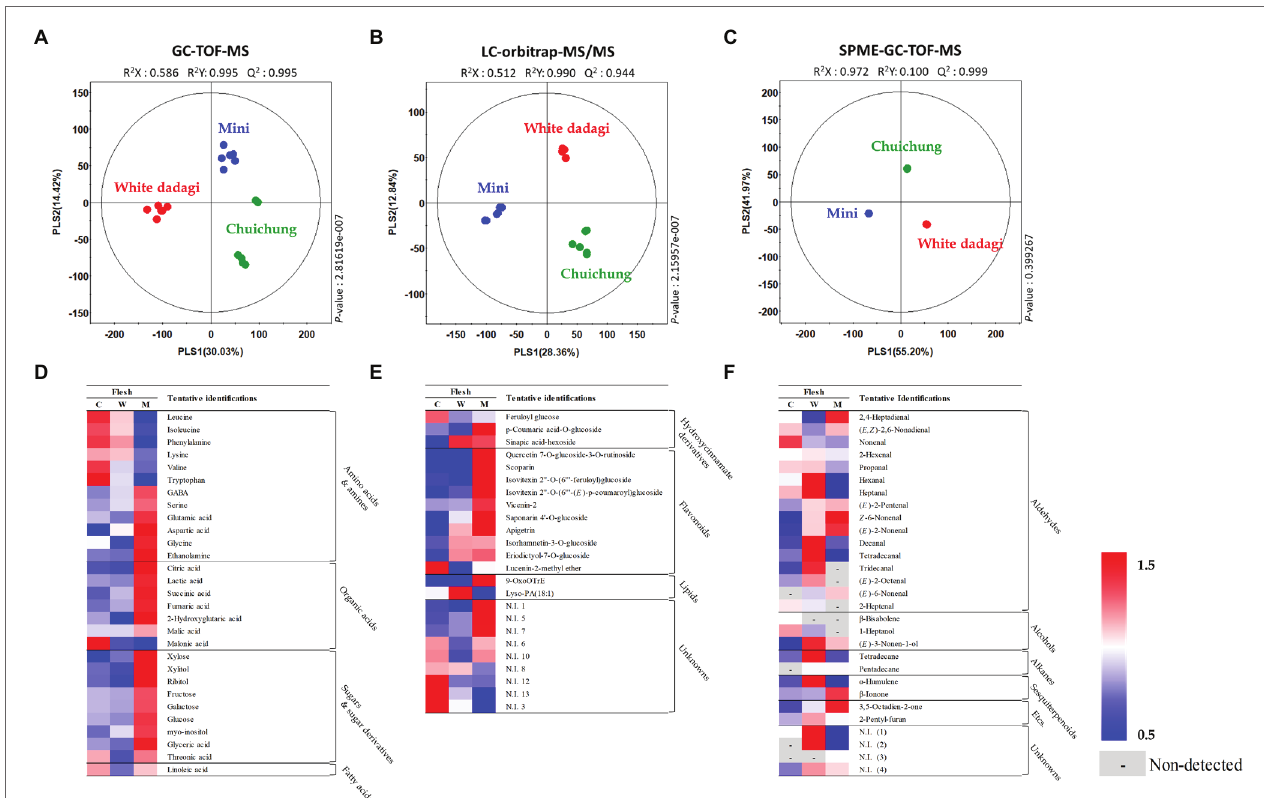
FIGURE 5 | Partial least squares-discriminant analysis (PLS-DA; A – C ) score plots for metabolites in three different cucumber flesh based on GC-TOF-MS ( A ), UHPLC-LTQ-Orbitrap-MS/MS ( B ), and HS-SPME-GC-TOF-MS ( C ) data set. Heat map analysis of different cucumber flesh based on GC-TOF-MS ( D ), UHPLC-LTQ- Orbitrap-ESI-MS/MS ( E ), and HS-SPME-GC-TOF-MS ( F ) data. Heat map representation of the relative abundance of significantly discriminant metabolites (VIP > 0.7, p < 0.05) based on PLS-DA model. Flesh of Chuichung ( ), White Dadagi ( ), and Mini ( ) samples. GC-TOF-MS, gas chromatography time-of-flight mass spectrometry; UHPLC-LTQ-Orbitrap-MS/MS, ultrahigh-performance liquid chromatography–linear trap quadrupole-orbitrap–tandem mass spectrometry; HS-SPME- GC-TOF-MS, headspace-solid phase microextraction gas chromatography time-of-flight mass spectrometry; VIP, variable importance projection; PLS-DA, partial least squares-discriminant